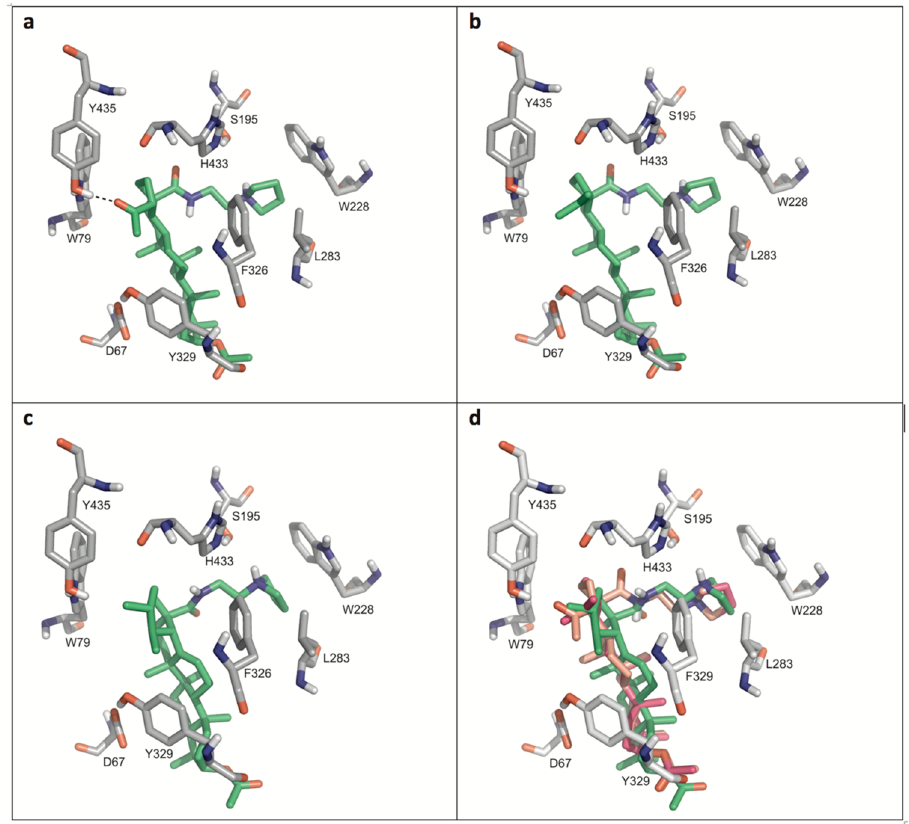
Figure 4. Details of the most favored docking arrangements of 35 ( a ), 34 ( b ) and 31 ( c ). ( d ) An overlay of all three ligands (orange colored: carbon atoms of 35 ; magenta colored: carbon atoms of 34 ; green colored: carbon atoms of 31 ). Hydrophobic interactions with the side chains of W79, W228, L283, Y329, and F326 preferentially stabilize the docking poses. As for 35 ( a ) a hydrogen bond with Y435 is formed which might explain the higher affinity compared to the other compounds.